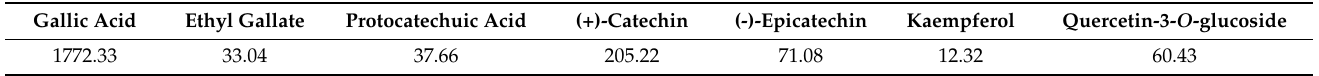
Table 1. The main phenolic compounds in the grape pomace extract ( µ g/g). Gallic